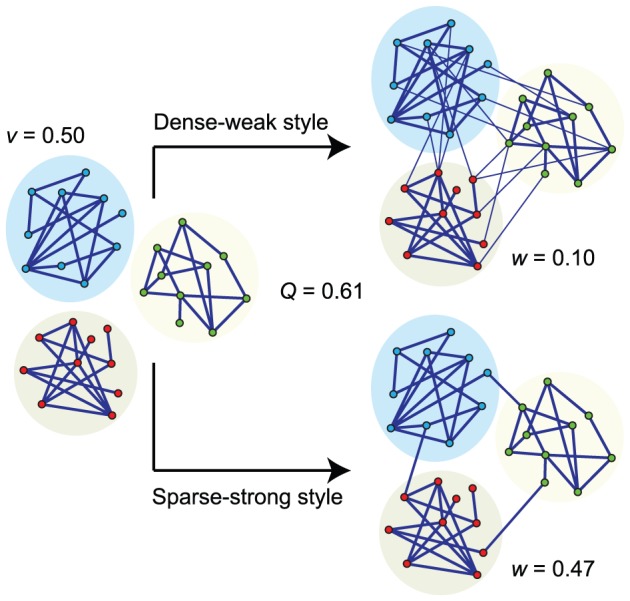
Schematic illustration of sparse-strong and dense-weak styles of weighted community networks.The large circles denote the communities of the network, and the small circles denote the nodes. The lines denote the edges of the network, and its width represents the weight of the edges (i.e., the transmission rate between two nodes). The network parameters are: N = 3 (number of communities), M = 10 (number of nodes in each community), dI = 3 (average internal degree), dE = 0.2 or 1 (average external degree), v = 0.5 (weight of internal edges) and w = 0.10 or 0.47 (weight of external edges). The modularity Q = 0.61 for both styles.